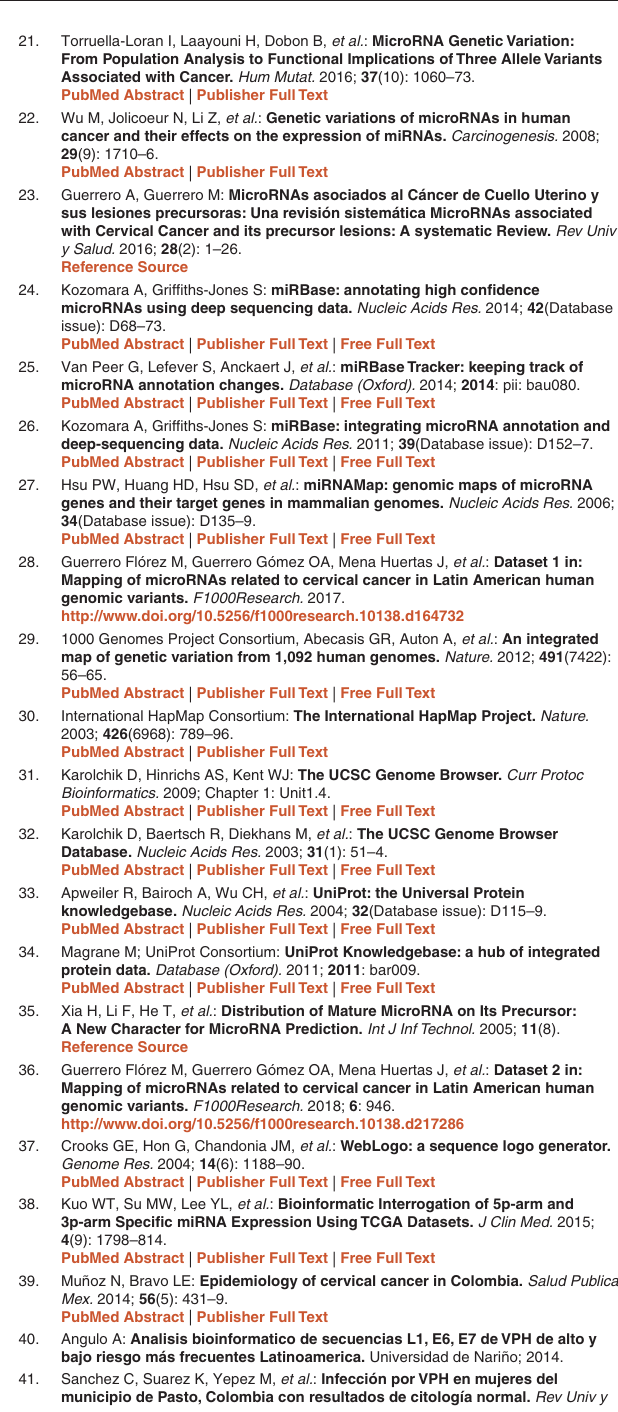
Supplementary File 3. miRNAs identified in HPV integration sites, displaying the nucleotide variations in the selected Latin American human genome variants and in the control